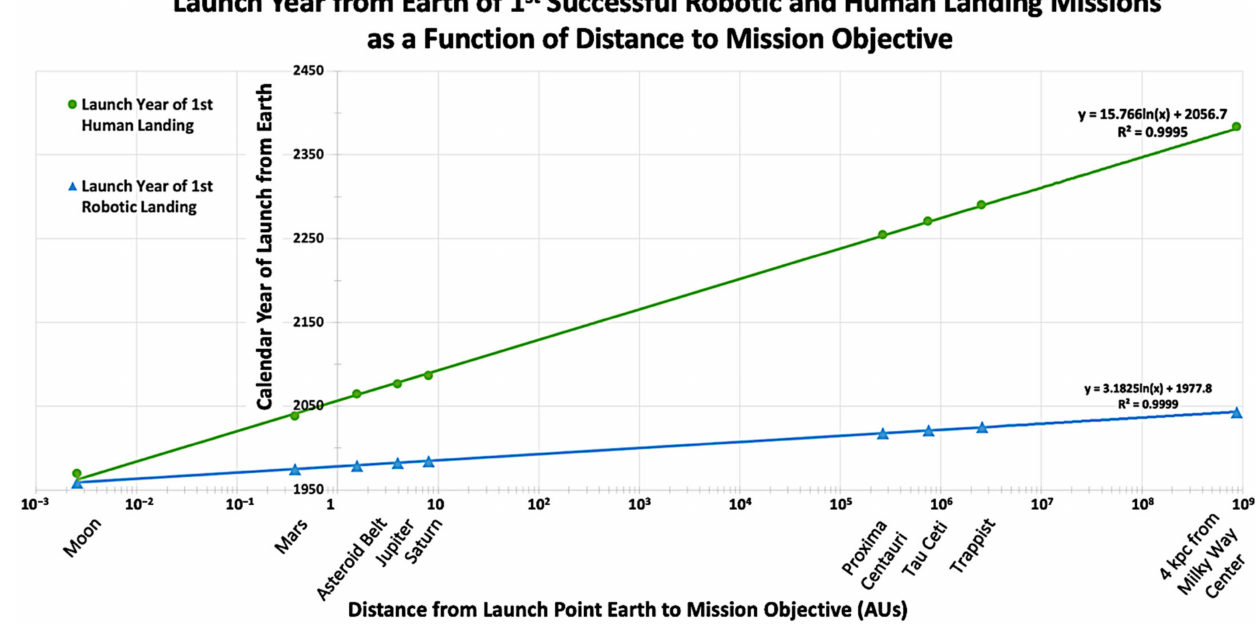
Figure 4. Graphical representation of data in Table 1 for launch date from Earth space of robotic and human landing missions having destinations ranging from the Moon to approximately 14,000 lightyears from the Solar